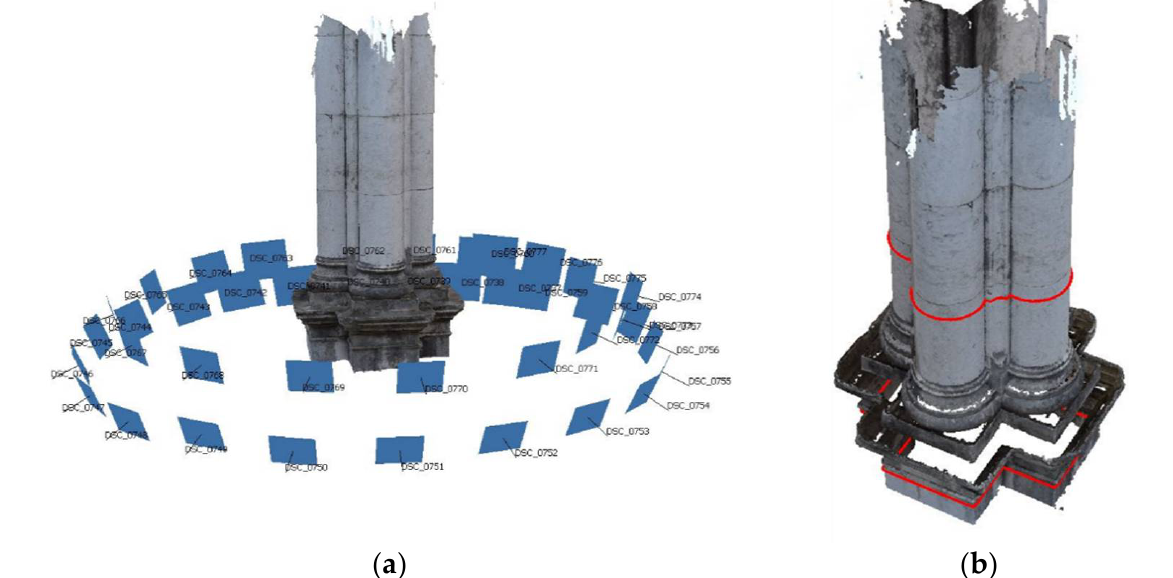
Figure 5. ( a ) Partial photogrammetry of a column performed at the Carmo convent, displaying all locations around the object in blue; ( b ) cross sections of the column shaft and pedestal obtained from the photogrammetry (marked in red).